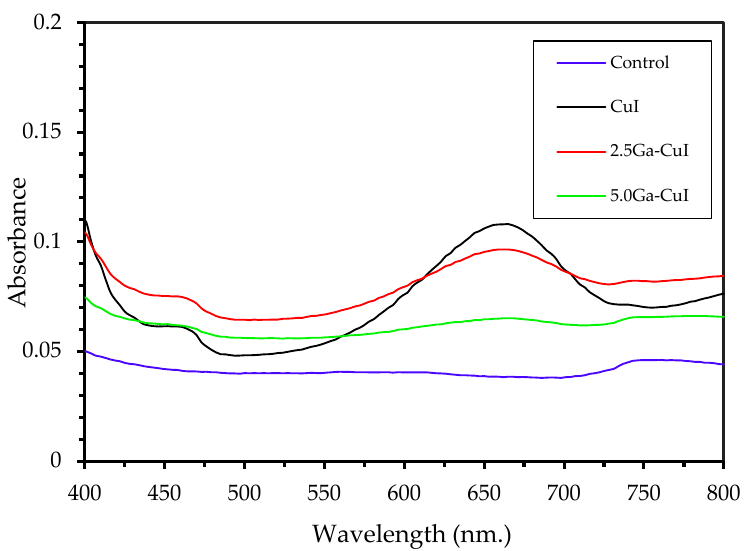
Figure 6. UV–Vis absorption spectra of 3,3 ′ ,5,5 ′ -tetramethyl-benzidine (TMB) oxidation, treated with acetate buffer (light blue), CuI (red), 2.5 GA-CuI (green) and 5.0 GA-CuI (blue).